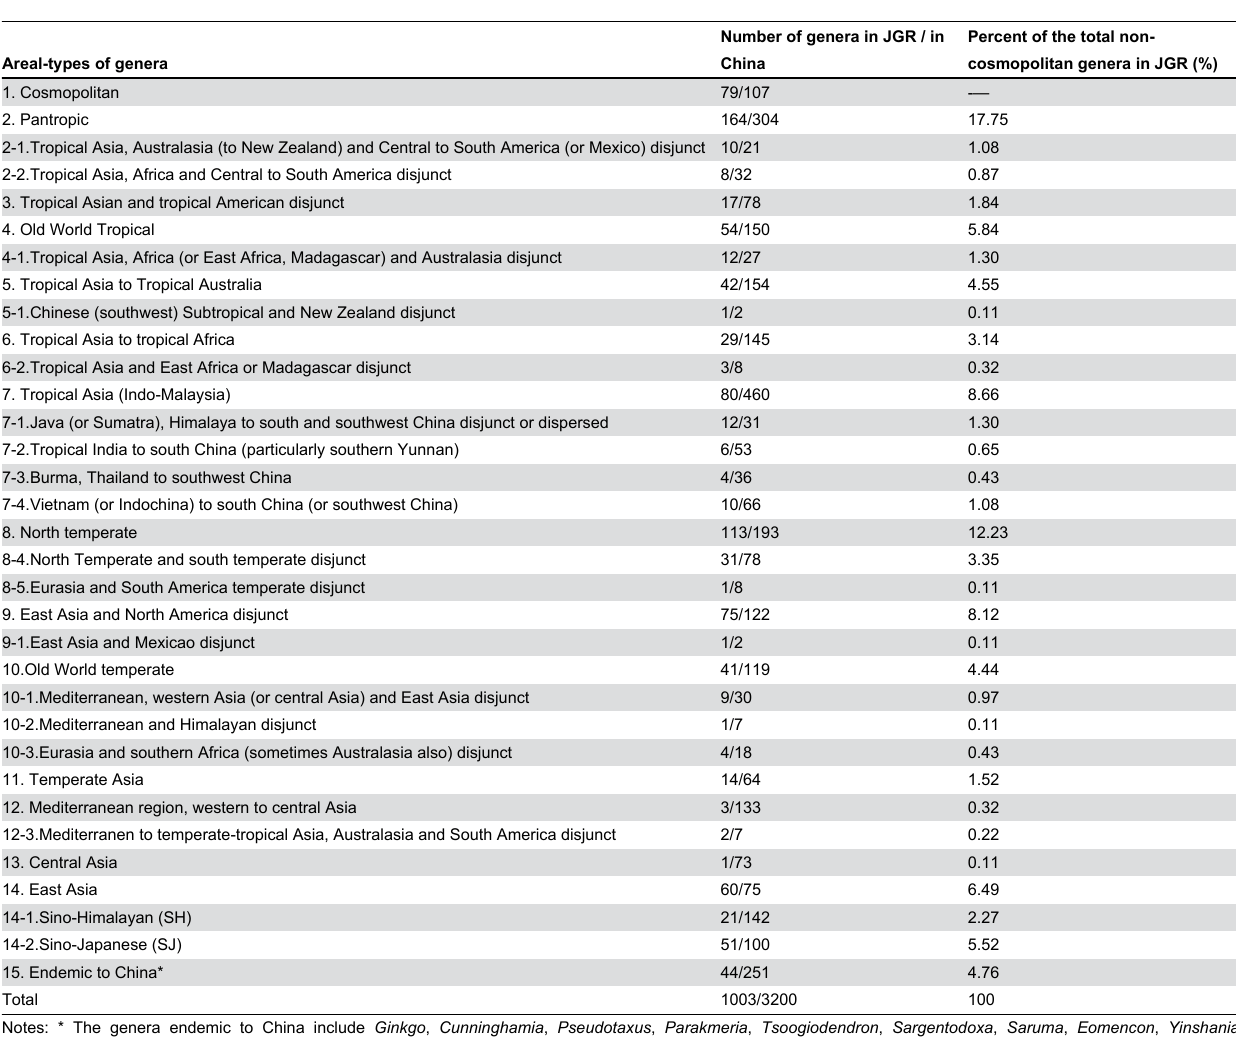
Table 10. Areal-types of genera from the seed plant flora of Mount Jinggangshan region